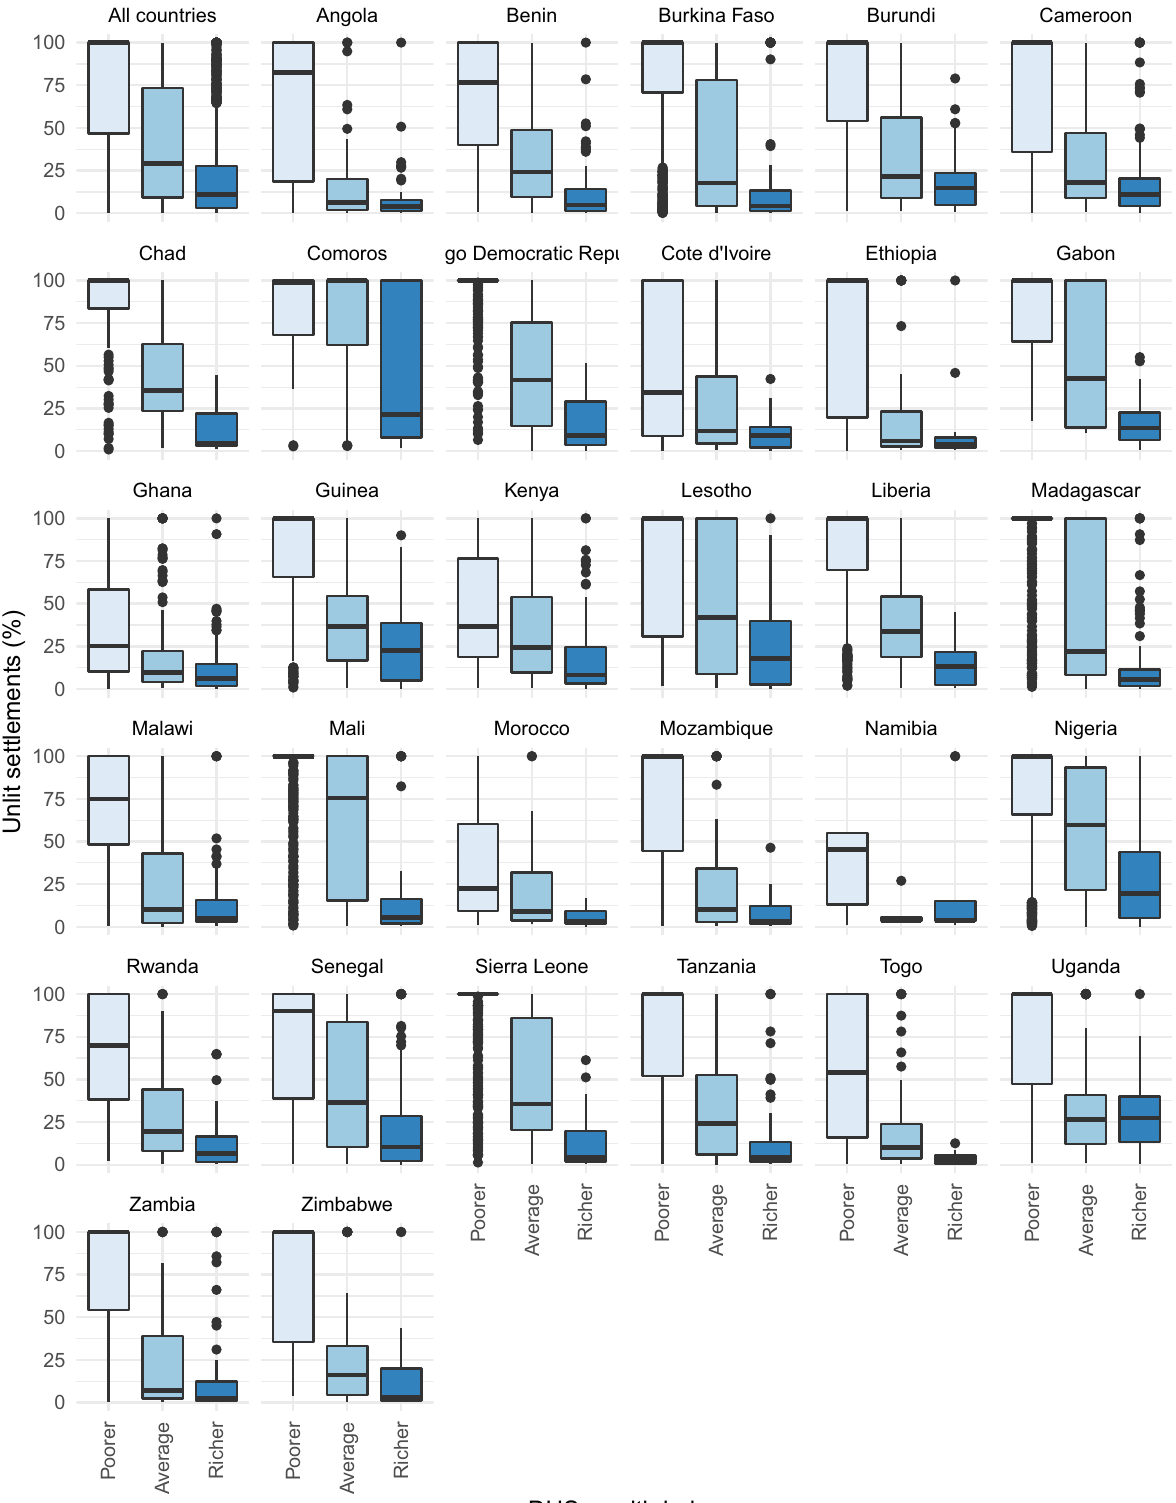
Fig. 2 Relationships between the Demographic and Health Surveys (DHS) wealth index categories (Poorer, Average Richer) and the percentage of unlit settlements for 31 African countries. The boxplots show the mean percentage area of unlit settlements within a 2 km buffer of a DHS urban household cluster and a 5 km buffer of a DHS rural household cluster against the mode of the wealth indices of all households assigned to the household cluster. The midline represents the median with the lower and upper limits of the box being the 1st and 3rd quartiles. The lower and upper whiskers represent minima/maxima no further than 1.5 times the interquartile range from the hinge. Outliers appear as